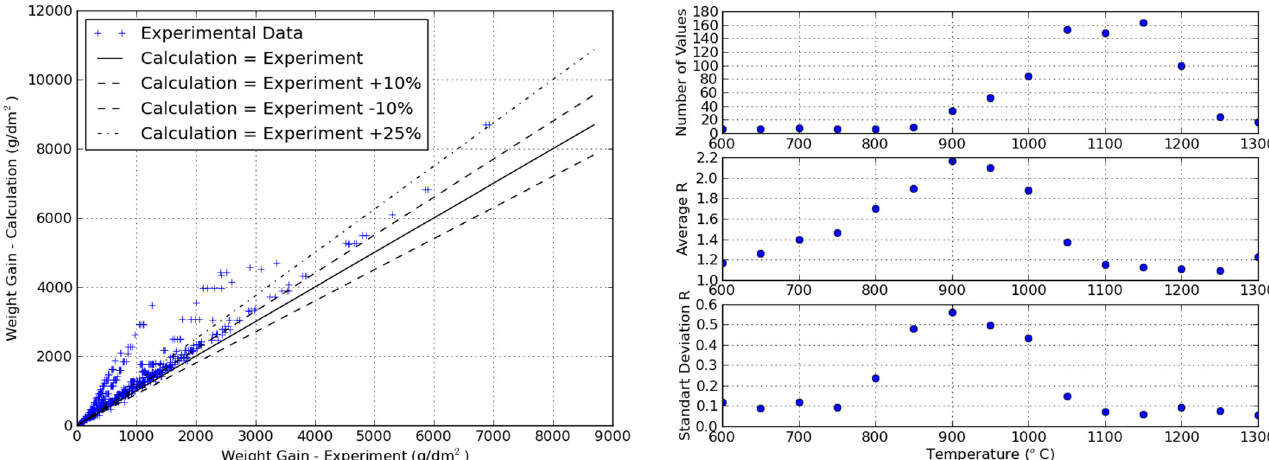
Fig. 7. Comparison of experimental and AEKI correlation data. Weight gain for all data (left) and R -parameter for each evaluated temperatures (right).